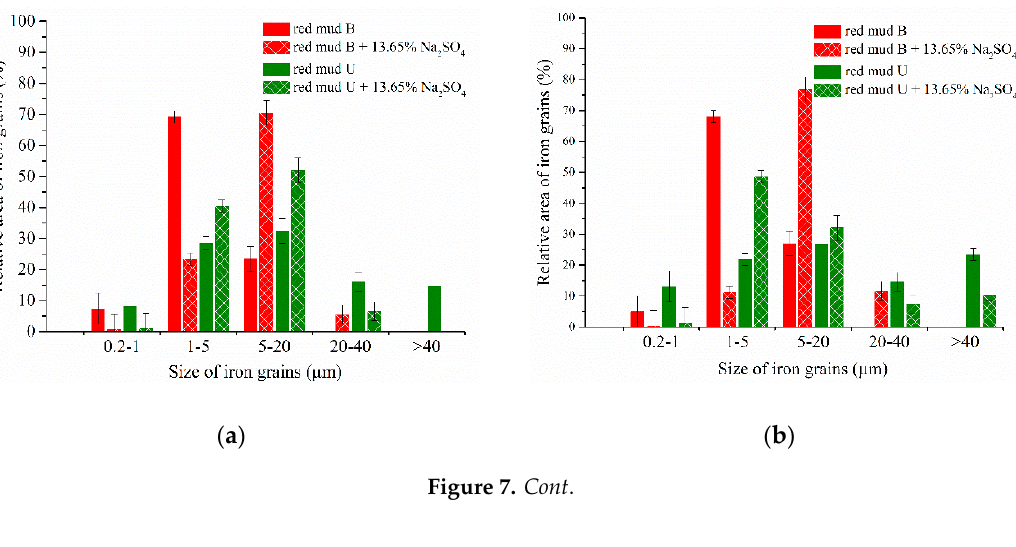
Table 4. General results with signs * of the roasting and magnetic separation of the samples B and U roasted at various temperatures and Na 2 SO 4 addition during 180